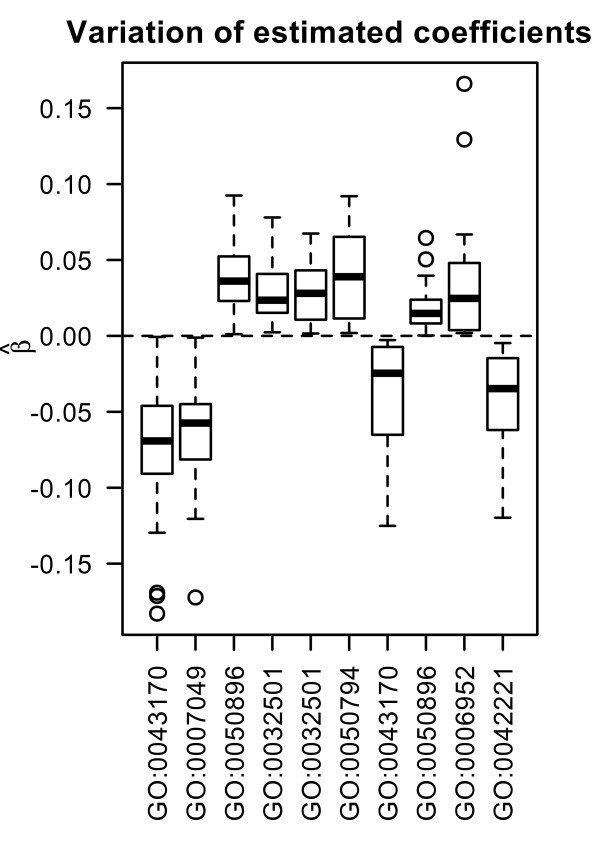
Variation of estimated regression coefficients. Boxplots show variation of estimated regression coefficients in the cox regression model for the most frequently chosen clusters from Table 2, represented via medoid genes.